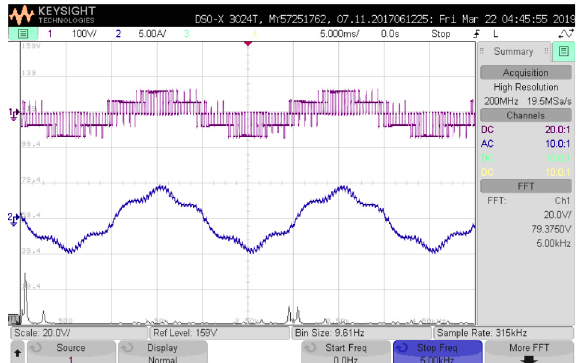
Figure 5. Voltage (top) and current (middle) waveforms of the phase a along with the voltage spectrum (bottom) for the reference voltage m 1 = 0.92 and m 2 = 0.23.